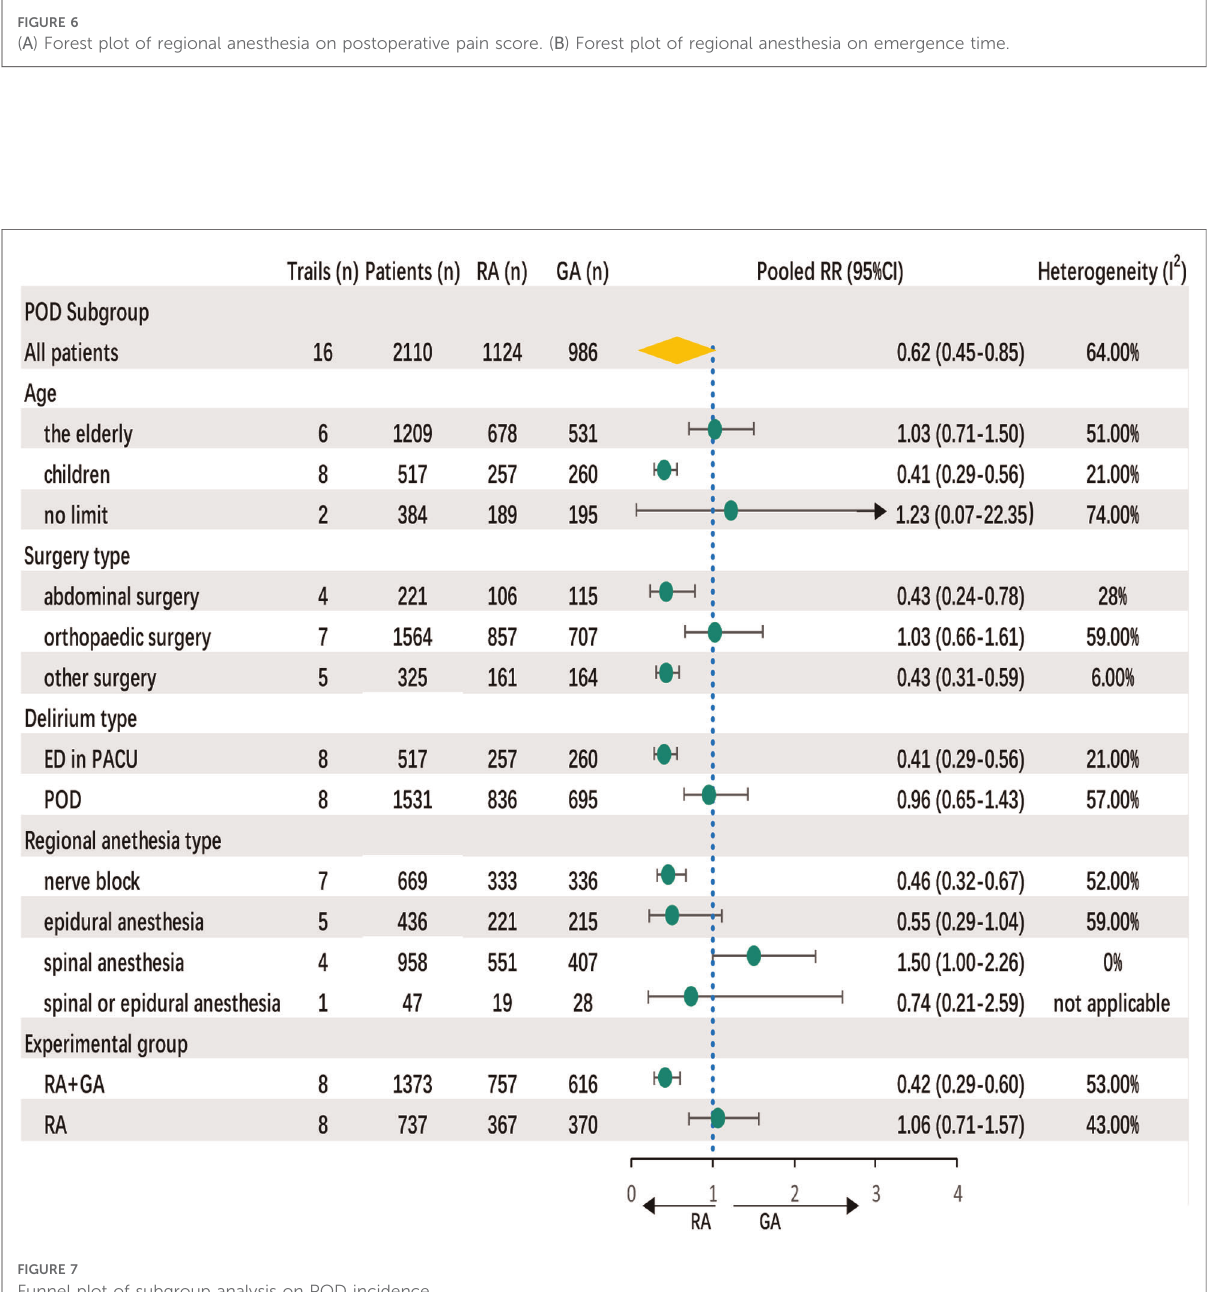
FIGURE 7 Funnel plot of subgroup analysis on POD